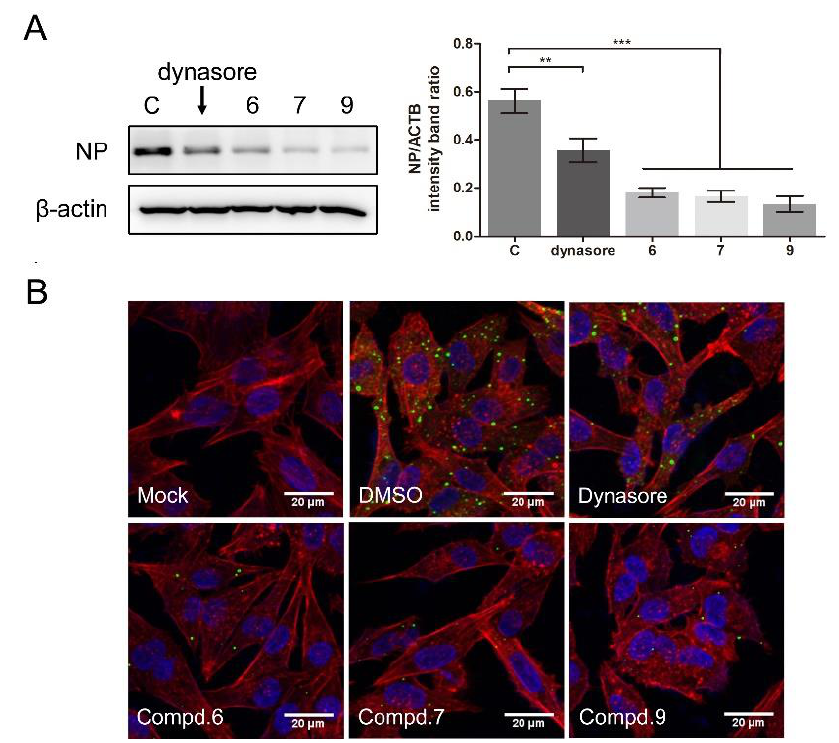
Figure 6. 1-Formyl- β -carboline derivatives inhibit NDV entry. ( A , B ) DF-1 cells were infected with F48E9 (MOI = 5) at 4 °C for 1 h. Unbound viruses were washed away by pre-chilled PBS. Next, cells were supplemented with different medium- containing compounds (dynasore: 100 μM; com- pounds 6/7/9: 20 μM). At 4 h post -infection, the viral protein was measured by Western blot ( A : left panel). The NP protein levels relative to ACTB levels were determined by densitometry ( A : right panel). The entry of virus was measured by indirect immunofluorescence ( B ). The statistical sig- nificance was analyzed using a two-tailed Student ’s t -test: ** p < 0.01; *** p < 0.001.